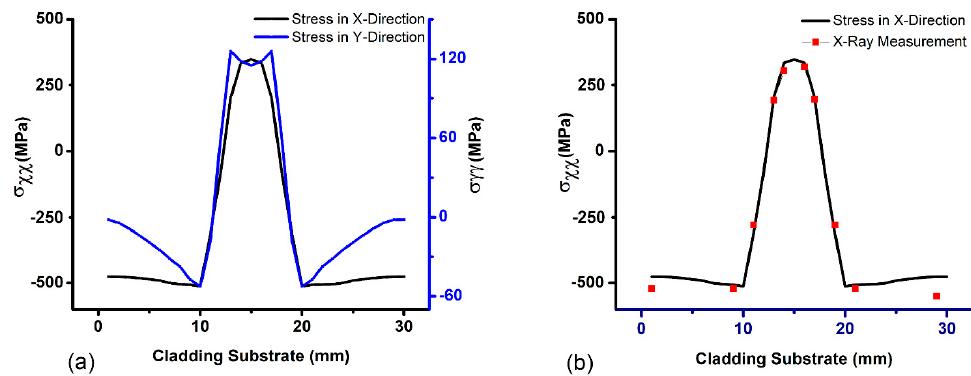
Figure 11. ( a ) Longitudinal and transverse residual stress. ( b ) Experimental validation. Longitudinal stress ( 𝜎 (cid:3051)(cid:3051) ) is further compared with experimentally determined values of residual stress to validate FEM results in the build direction. Overall results demon- strated a precise agreement with XRD results, with a slight deviation on the extreme ends.